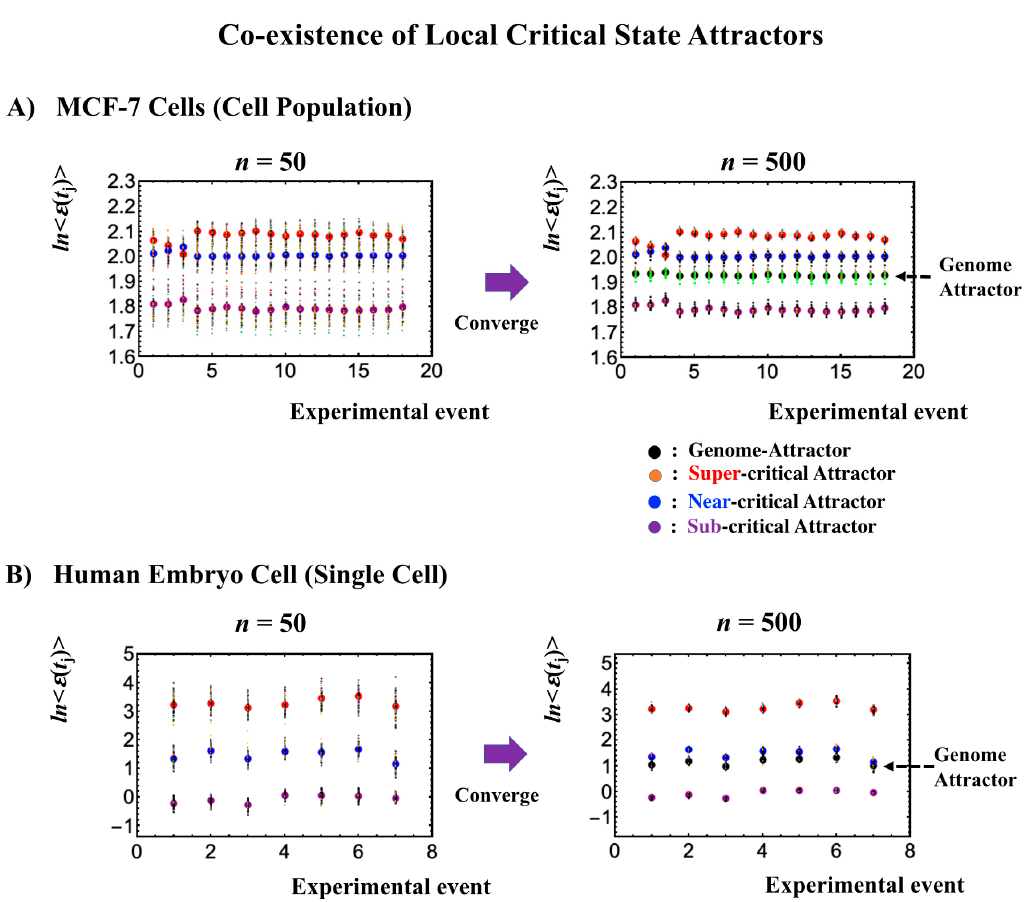
Figure 11. Local critical state attractors. Panels ( A ) for MCF-7 cells and ( B ) for human embryo cells illustrate that bootstrapping highlights that the convergence of the center of mass (CM) of randomly selected expression, n = 50 and n = 500 expressions, selected from a critical state converges to the CM of the critical state. For each random sampling, 40 repetitions were computed over experimental time points as depicted by each of the small circles. Large colored circles represent the CM of critical states (red: super-critical; blue: near-critical; purple: sub-critical state; see the number of expressions in local critical states in Table 1 and Table 2). The x -axis and y -axis correspond to experimental time points (Section 4.1) and the natural logarithm of the average of group expression, respectively. These confirm the existence of local critical states, and furthermore, their CM corresponds to local attractors (also confirmed in other biological regulations). Note: A mixture of critical states does not converge to the CM (see Figure 3 in [8]), showing that the genome attractor develops to form a heteroclinic critical-state attractor